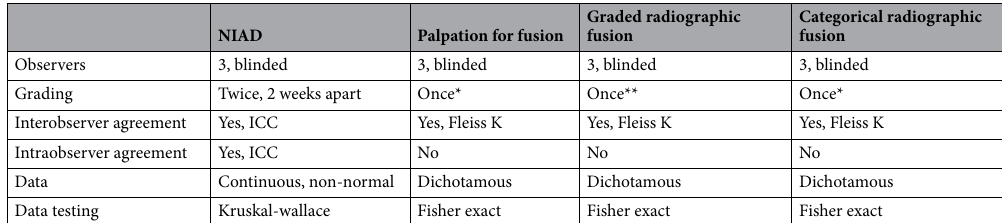
Table 1. NIAD, Manual Palpation and Radiographic Evaluation Rubric. *Raters grade as fused or not, and specimen is assigned status by rater majority. ** Raters grade 0–2, scores are summed, and sum determines status. Sum ≥ 5 is